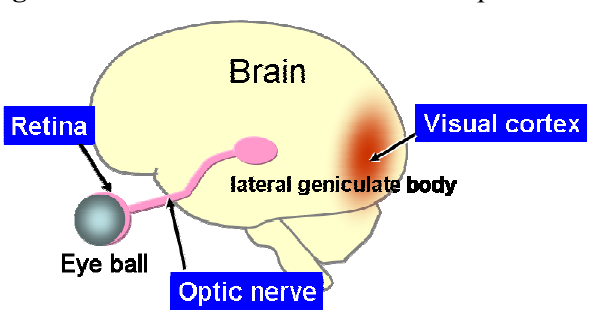
Figure 5. Stimulation sites of the retinal